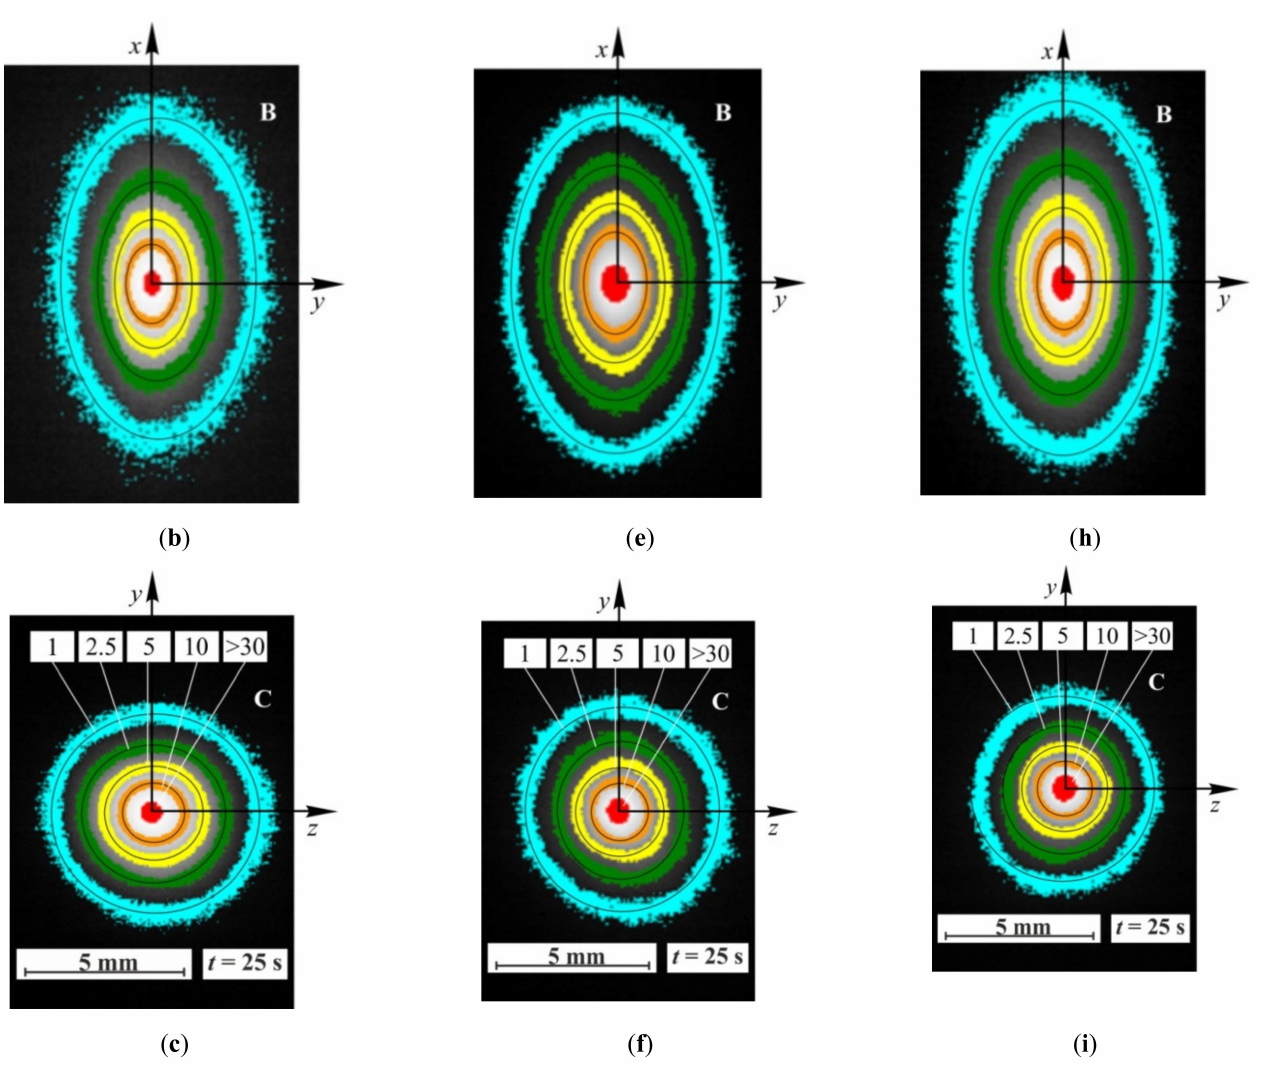
Figure 3. Thermal images for pine ( a – c ), oak ( d – f ), and lime ( g–i ) at A, B, and C faces: along the fibers, radial cut ( a , d , g ), along the fiber, tangential cut ( b , e , h ), and crosscut across the fibers ( c , f , i ). The number on the isotherms indicates the overheating temperatures above the ambient temperature: 1 ± 0.25, 2.5 ± 0.5, 5.0 ± 0.5, 10 ± 2, and >30 ◦ C; t —time after heating